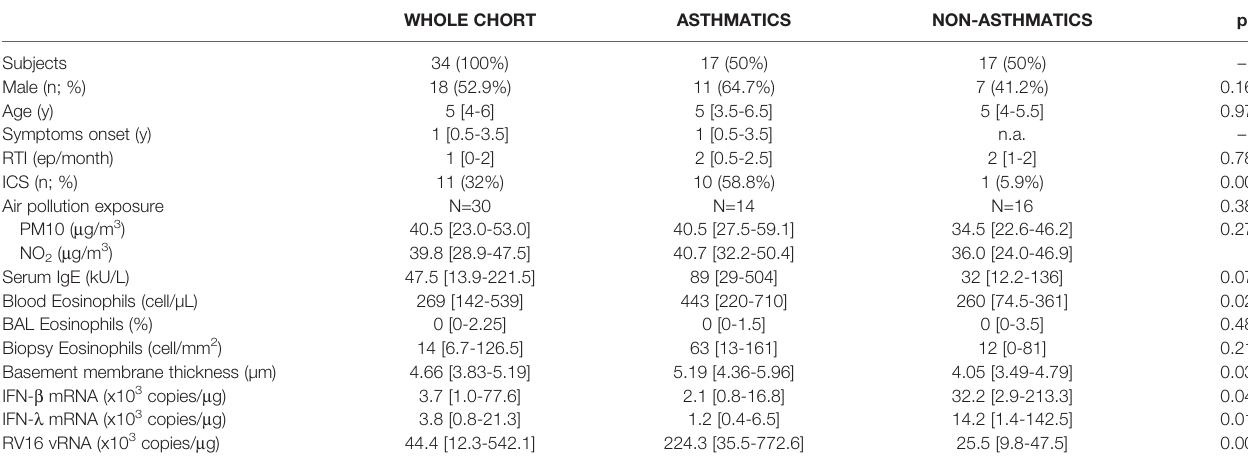
TABLE 1 | Description of the whole cohort and comparison between asthmatic and non-asthmatic